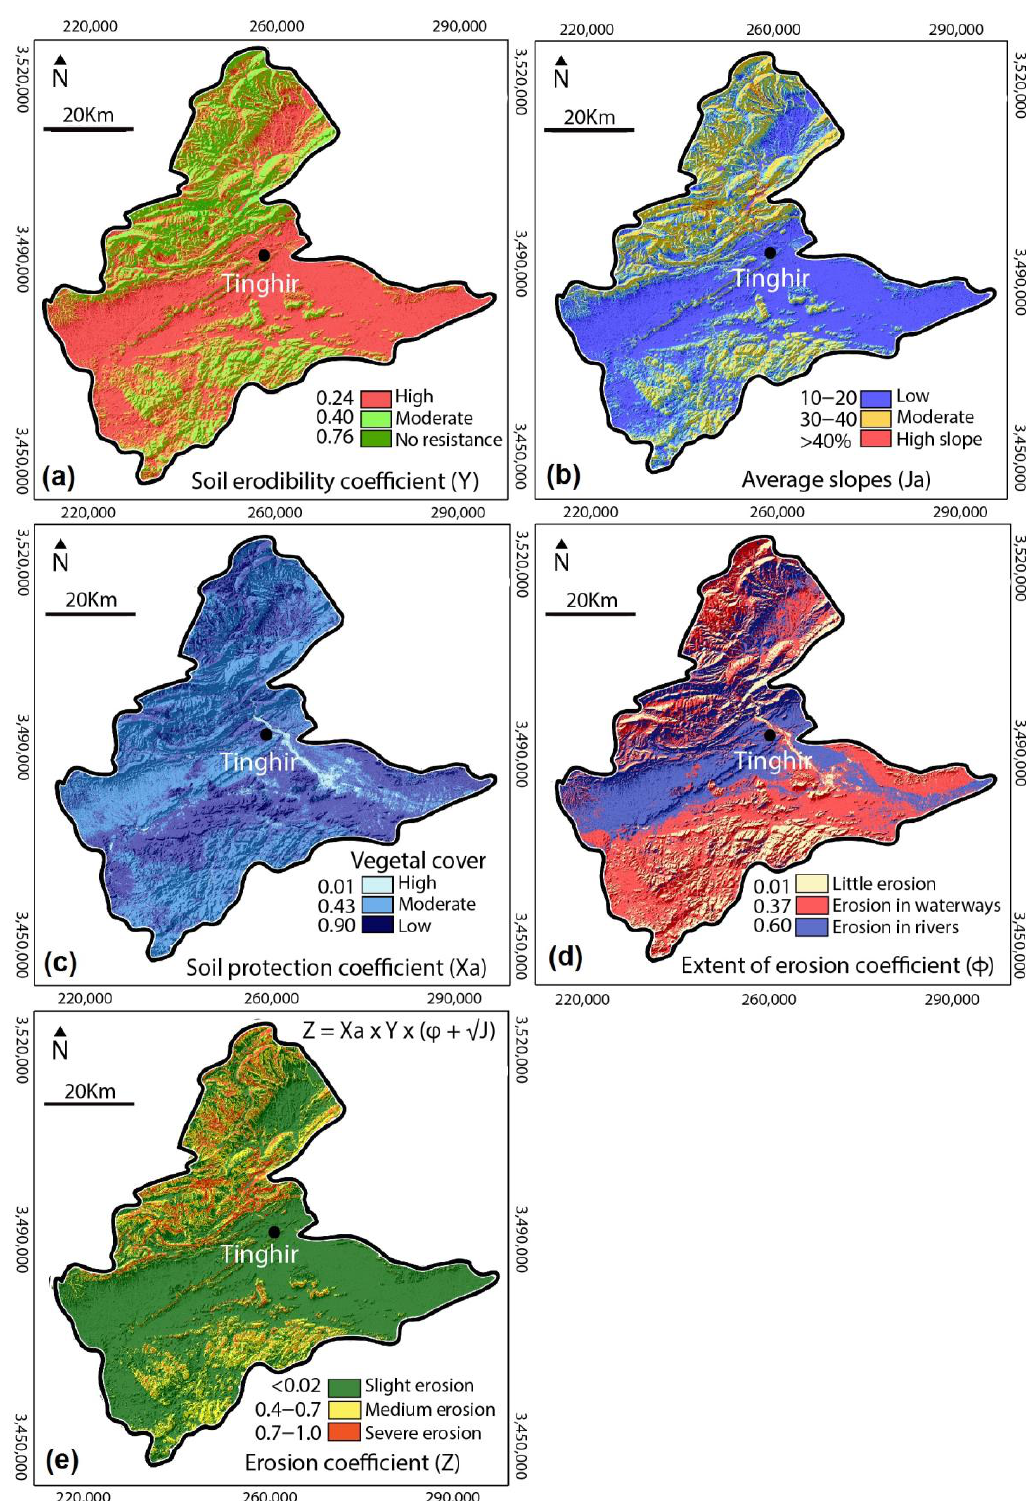
Figure 6. Digital maps of the EPM model parameters ( a ): Y factor; ( b ): Xa factor; ( c ): Ja factor; ( d ): Φ factor; ( e ): the erosion coefficient Z of the Toudgha River catchment.